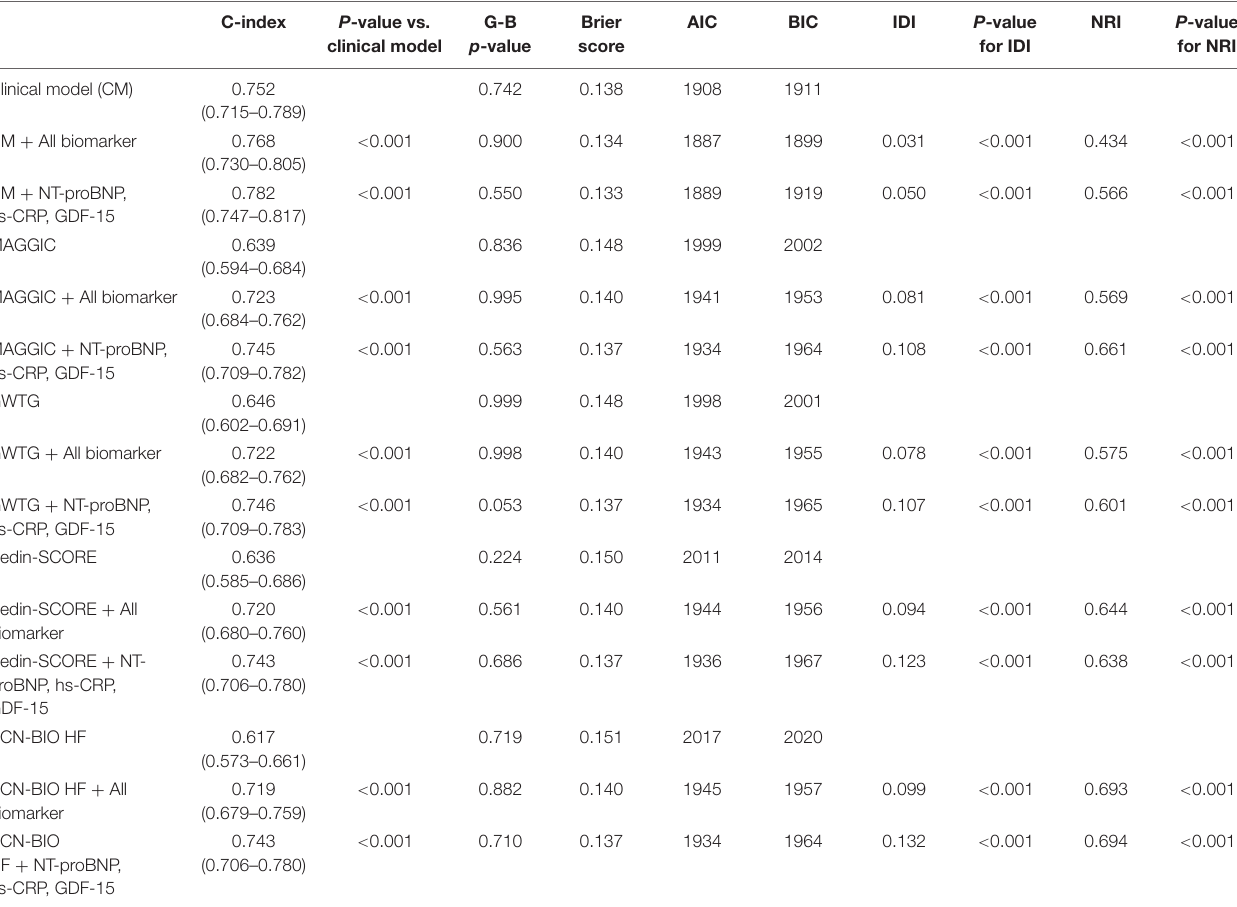
TABLE 3 | Added prognostic value of a multi-biomarker 2-point-based risk stratification strategy in acute heart failure to predict 12-month all-cause